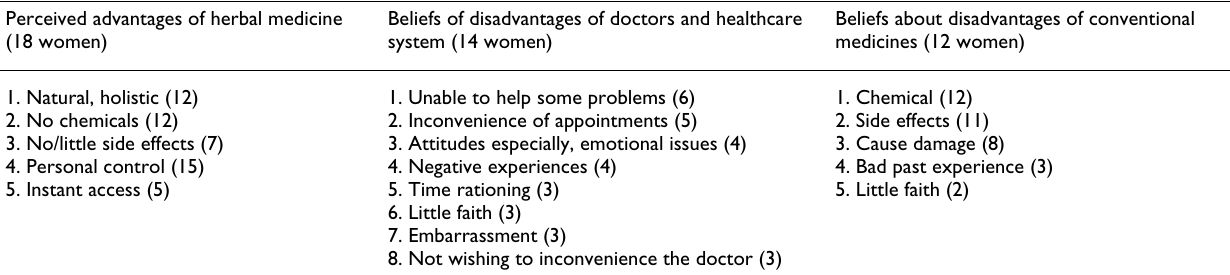
Table 2: Summary of Themes and Subcategories Around Motives for Herbal Use Perceived advantages of herbal medicine (18 women)